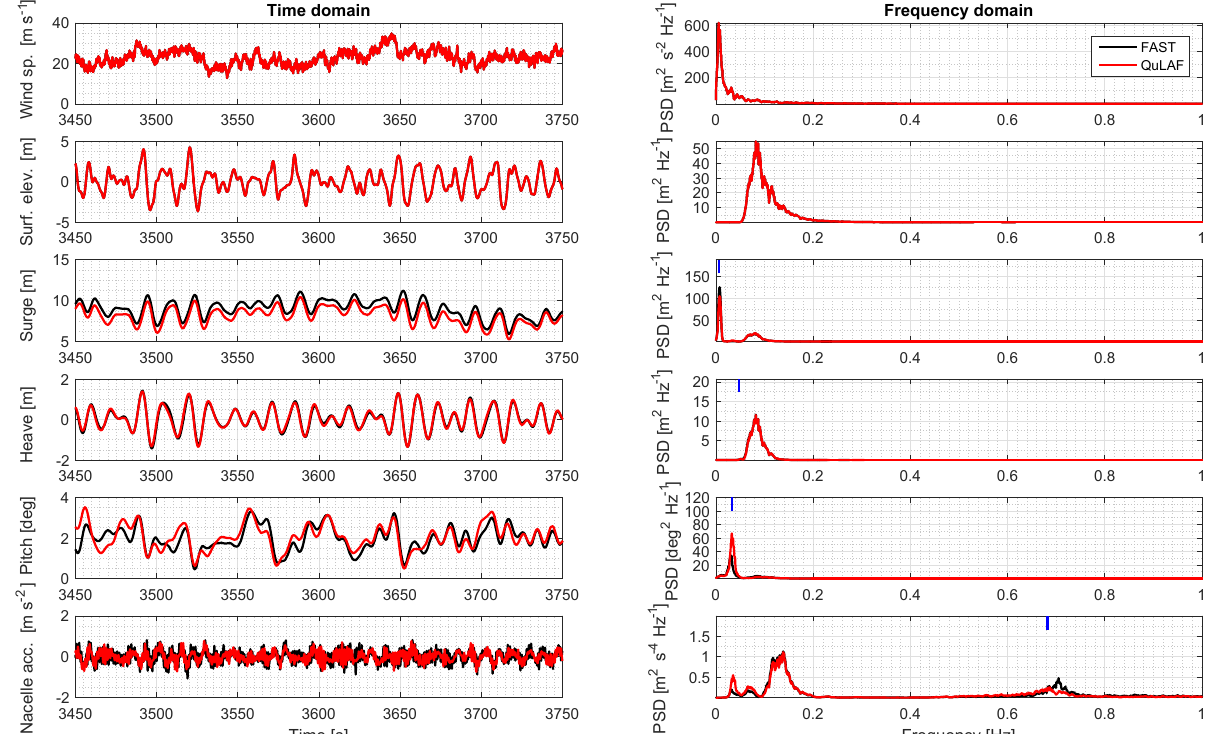
Figure 9. Response to irregular waves and turbulent wind in the time and frequency